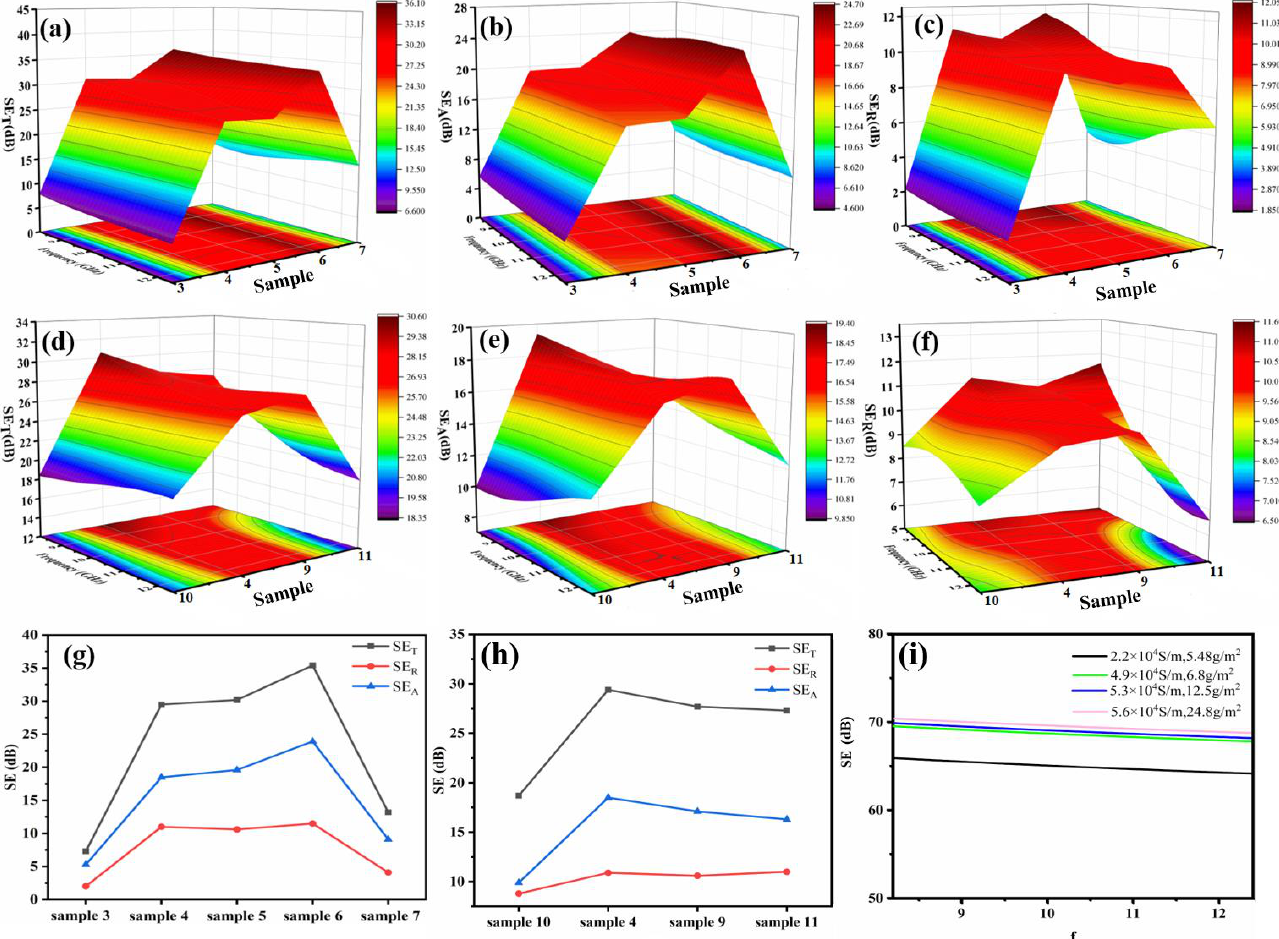
Figure 3. Three-dimensional presentation of ( a ) SE T , ( b ) SE A , ( c ) SE R of sample 3–7; three-dimensional presentation of ( d ) SE T , ( e ) SE A , ( f ) SE R of sample 9, 4, 8, 10; ( g , h ) trend of variation of SE at 9 GHz of samples; ( i ) fitted lines of CNTFs with different areal density by formula (1).